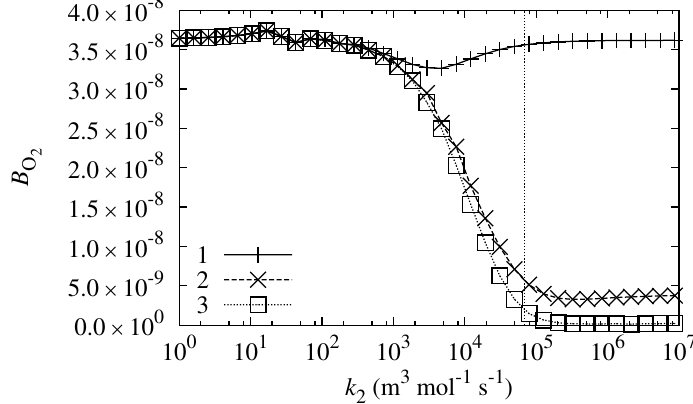
Figure 6. The biosensor response sensitivity, B , to oxygen dependence on reaction rate O 2 constant of Reaction (6), k , at different values of substrate concentration s : 0 . 498 mol/m 3 2 0 (1), 4 . 98 mol/m 3 (2) and 49 . 8 mol/m 3 (3). The vertical line marks the reaction rate constant, k , corresponding to 2